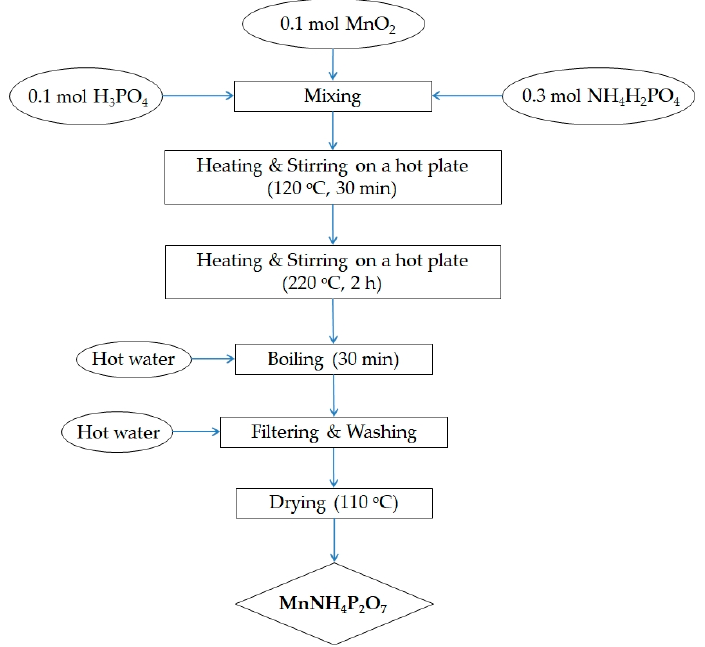
Figure 1. Flow chart for the preparation of manganese violet.